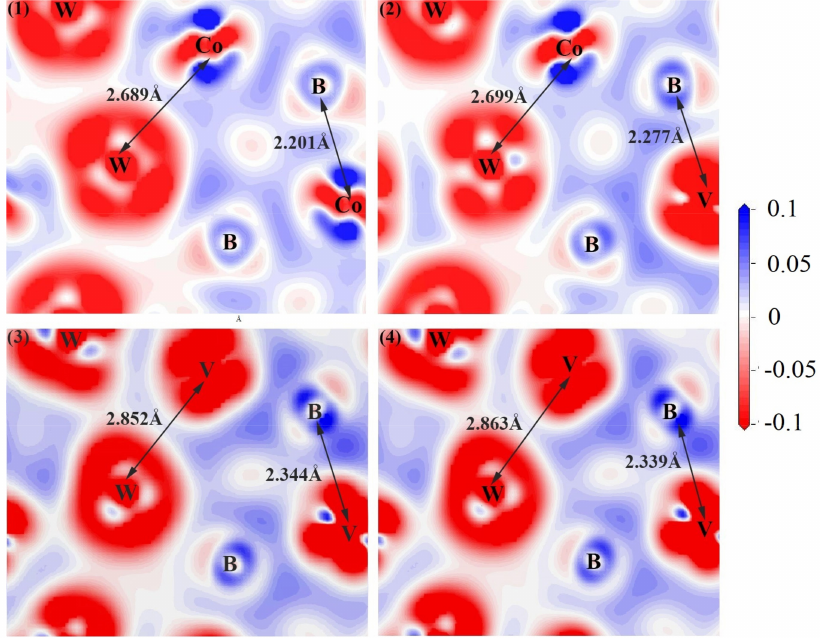
Figure 6. Illustration of charge density difference of V doped WCoB at different